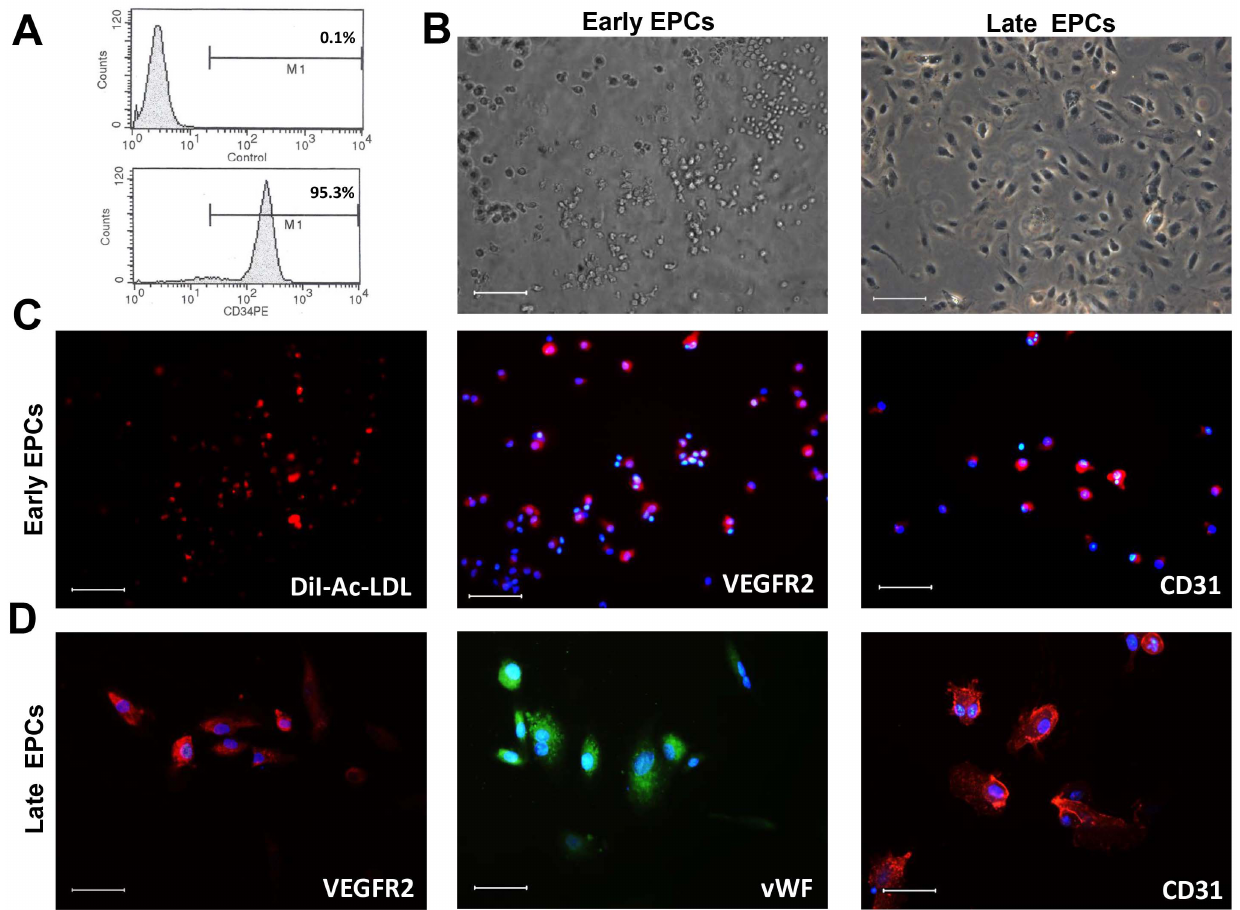
Figure 1. Flow cytometric analysis of CD34 + cells and morphological and immunophenotypical characterization of early and late EPCs. (A) Flow cytometric analysis of CD34 expression after isolation by anti-CD34 microbeads. Shown are representative data from 3 independent experiments using cells isolated from different cord blood with similar results. Isotype controls are used. (B) Early EPCs cultured for 7 days and late EPCs cultured for 14 days (Scale bar=100 m m, 200 6 magnification). (C)Early EPCs are shown to uptake DiI-Ac-LDL(red) (Scale bar=100 m m, 200 6 magnification). Immunocytochemistry of VEGFR2(red),CD31 (red), and DAPI(blue) was demonstrated in early EPCs (Scale bar=50 m m,400 6 magnification). (D) Immunocytochemistry of VEGFR2(red), vWF(green), CD31(red),and DAPI(blue) was demonstrated in late EPCs(Scale bar=50 m m,400 6 magnification). Shown are representative data from 3 independent experiments using early EPCs isolated from different cord blood and 3 independent experiments using late EPCs isolated from different cord